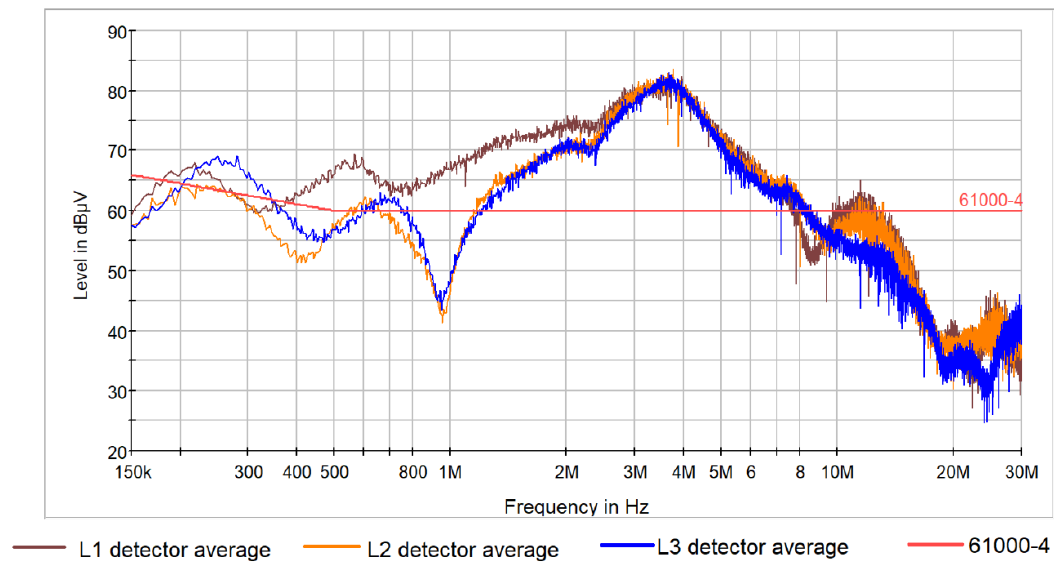
Figure 8. Measurement results — levels of conducted disturbances in the three-phase wires supplying the operating electrodes of the reactor.